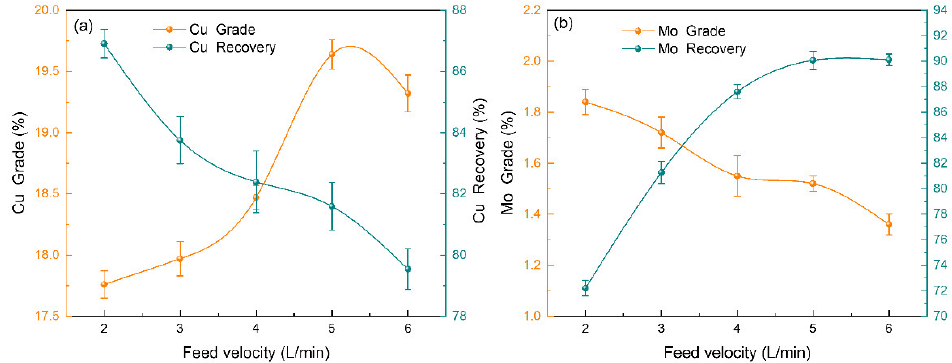
Figure 7. Effect of feed velocity on Cu-Mo separation at a magnetic induction of 7 T and a pulp concentration of 20%. ( a ) Cu recovery from magnetic products; ( b ) Mo recovery from non-magnetic products.